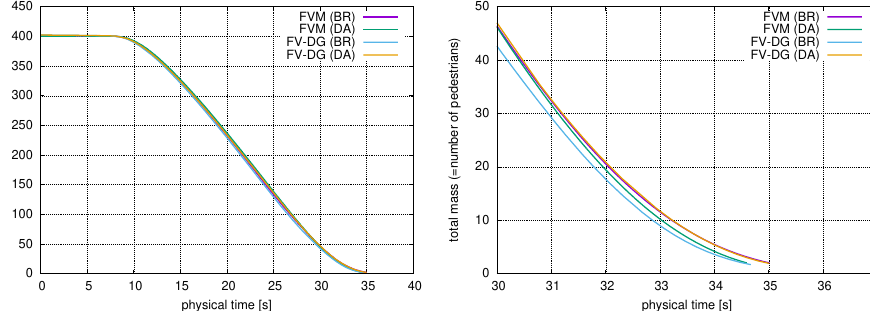
Figure 5. Domain with three circular obstacles, the time evolution of the total number of pedestrians M ( t m ) for the finest grid # T h = 11,660 (FV) and # T h = 11,636 (FV-DG), total view ( left ) and the detailed view close to the end of the evacuation ( right